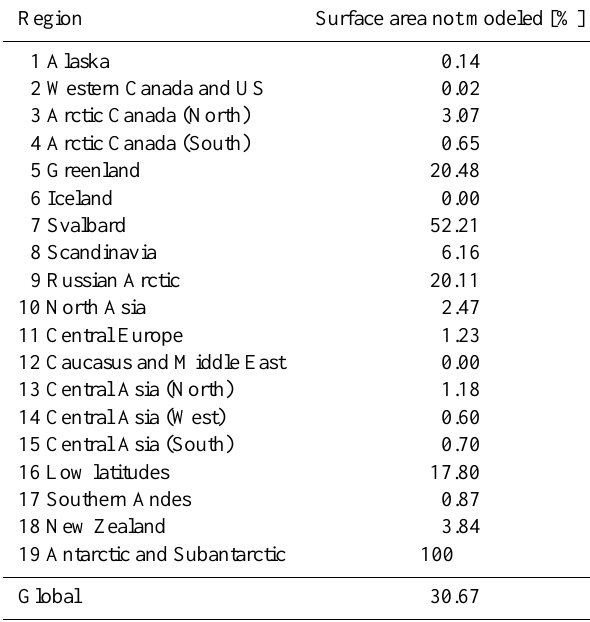
Table 2. Percentages of glacier surface area affected by data gaps or model failure for each region for the CRU-forced model (numbers very similar for the model forced by